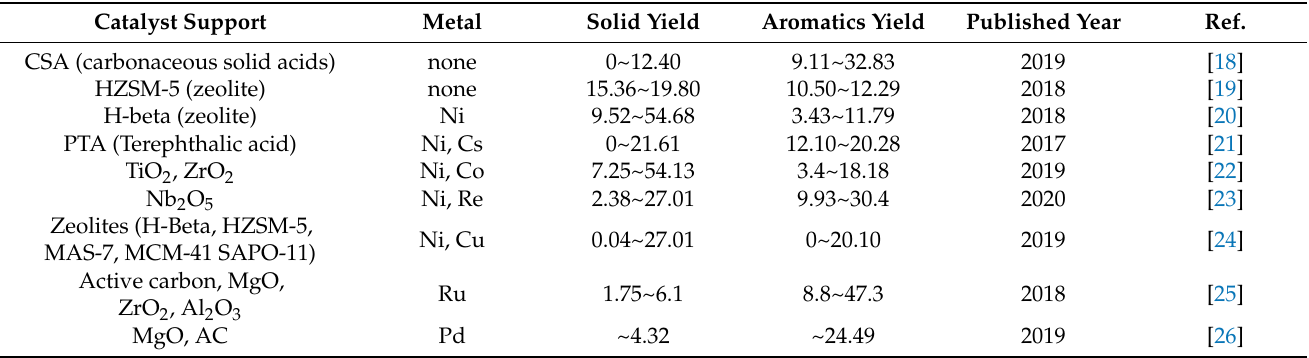
Table 1. Selected lignin hydrogenolysis papers comparison of catalyst and yields analyzed by